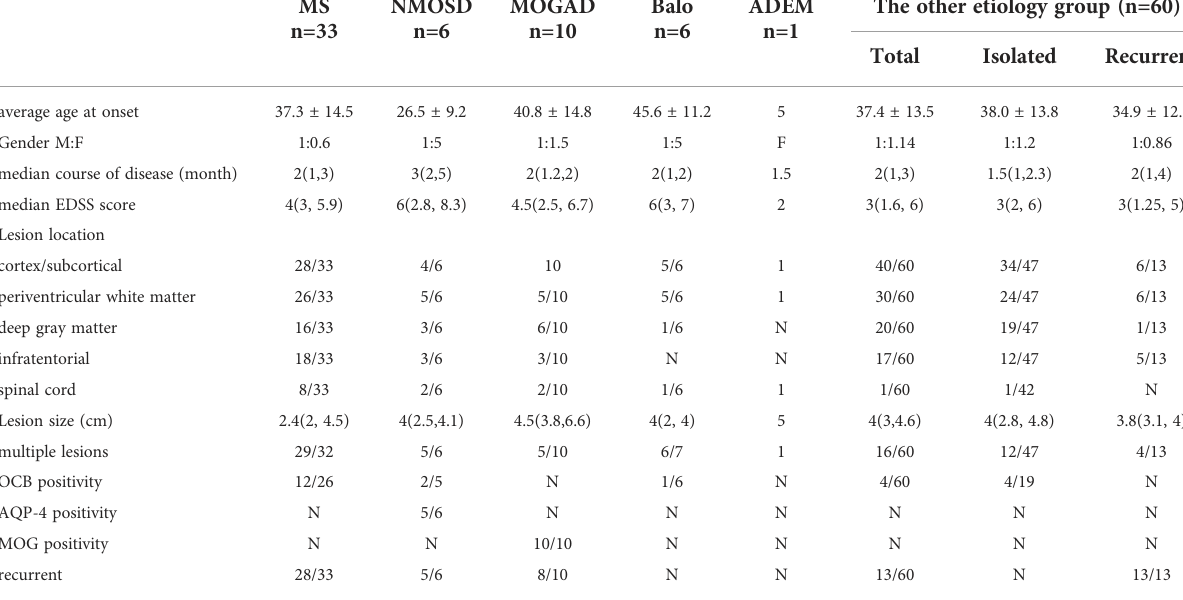
TABLE 1 clinical date on TDLs with different